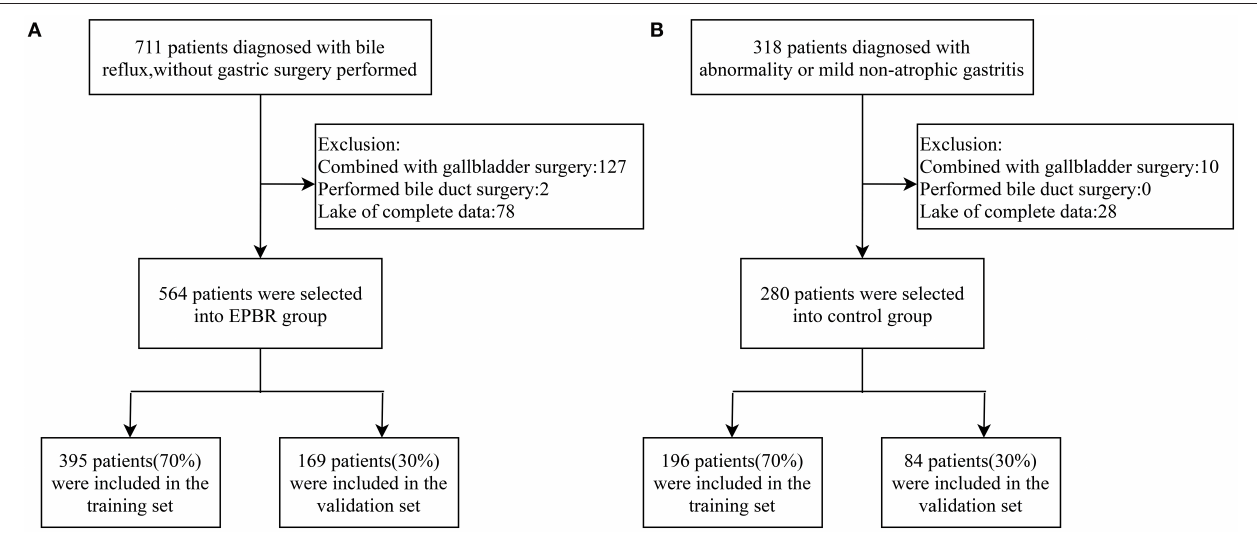
FIGURE 1 | Schematic diagram of screening process for primary bile reflux group (A) and control group (B)